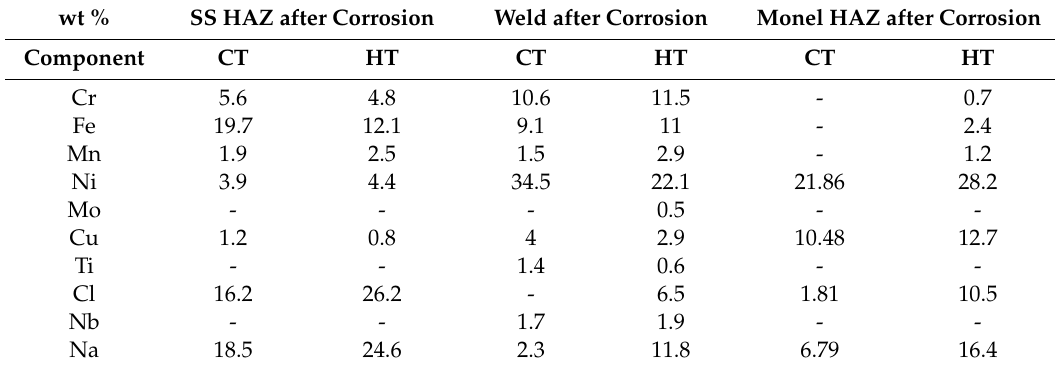
Table 2. Comparison of EDS wt % of CT and HT specimens at HAZ and welds zones cited. wt % SS HAZ after Corrosion